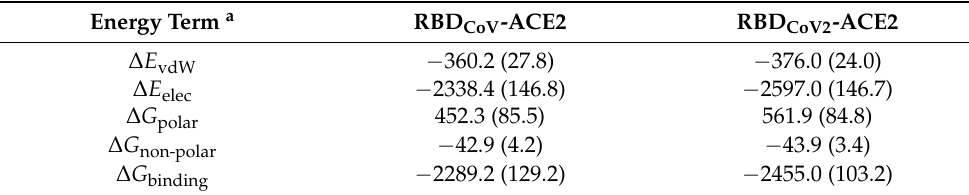
Table 1. Average values and corresponding standard deviations (shown in parentheses) of various MM-PBSA energy terms (kJ/mol) for the RBD CoV -ACE2 and RBD CoV2 -ACE2 complexes calculated over the respective 100 representative